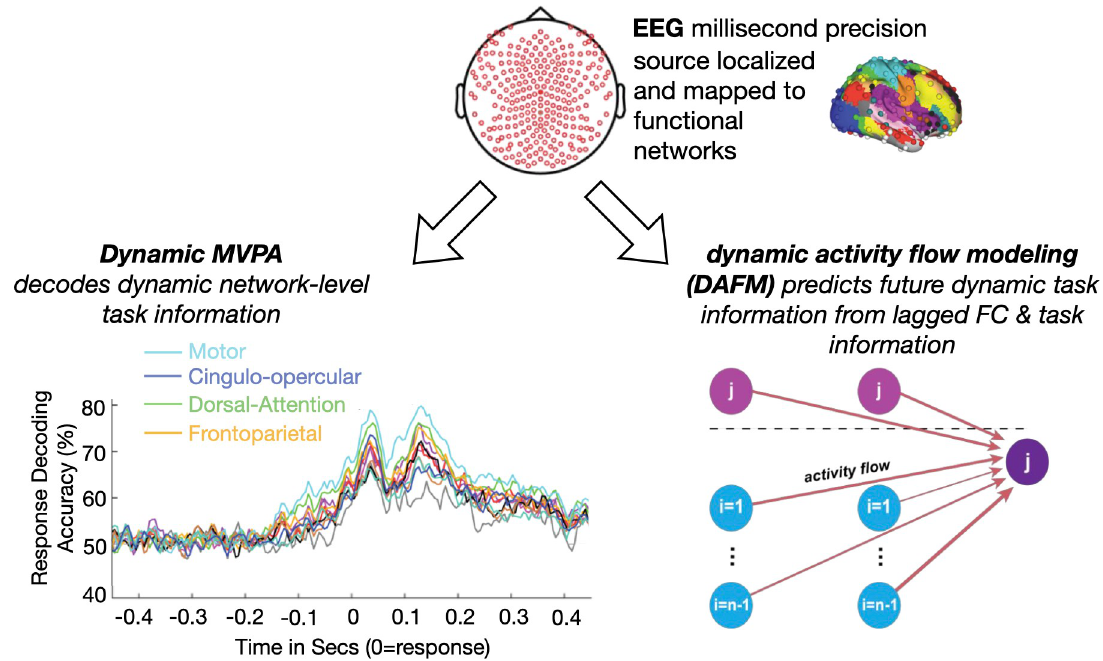
Fig 1. Mill and colleagues [3] study brain network interactions in task representations by combining EEG task and rest information source modeled to functional networks from previous fMRI results. Using MVPA in a sensory-motor task, they decode task information over time per network, finding motor and cognitive control networks are particularly prominent in decoding accuracy and temporal onset. Using DAFM, they predict future EEG task activity from lagged resting state EEG patterns and task activity. DAFM, dynamic activity flow modeling; EEG, electroencephalography; MVPA, multivariate pattern